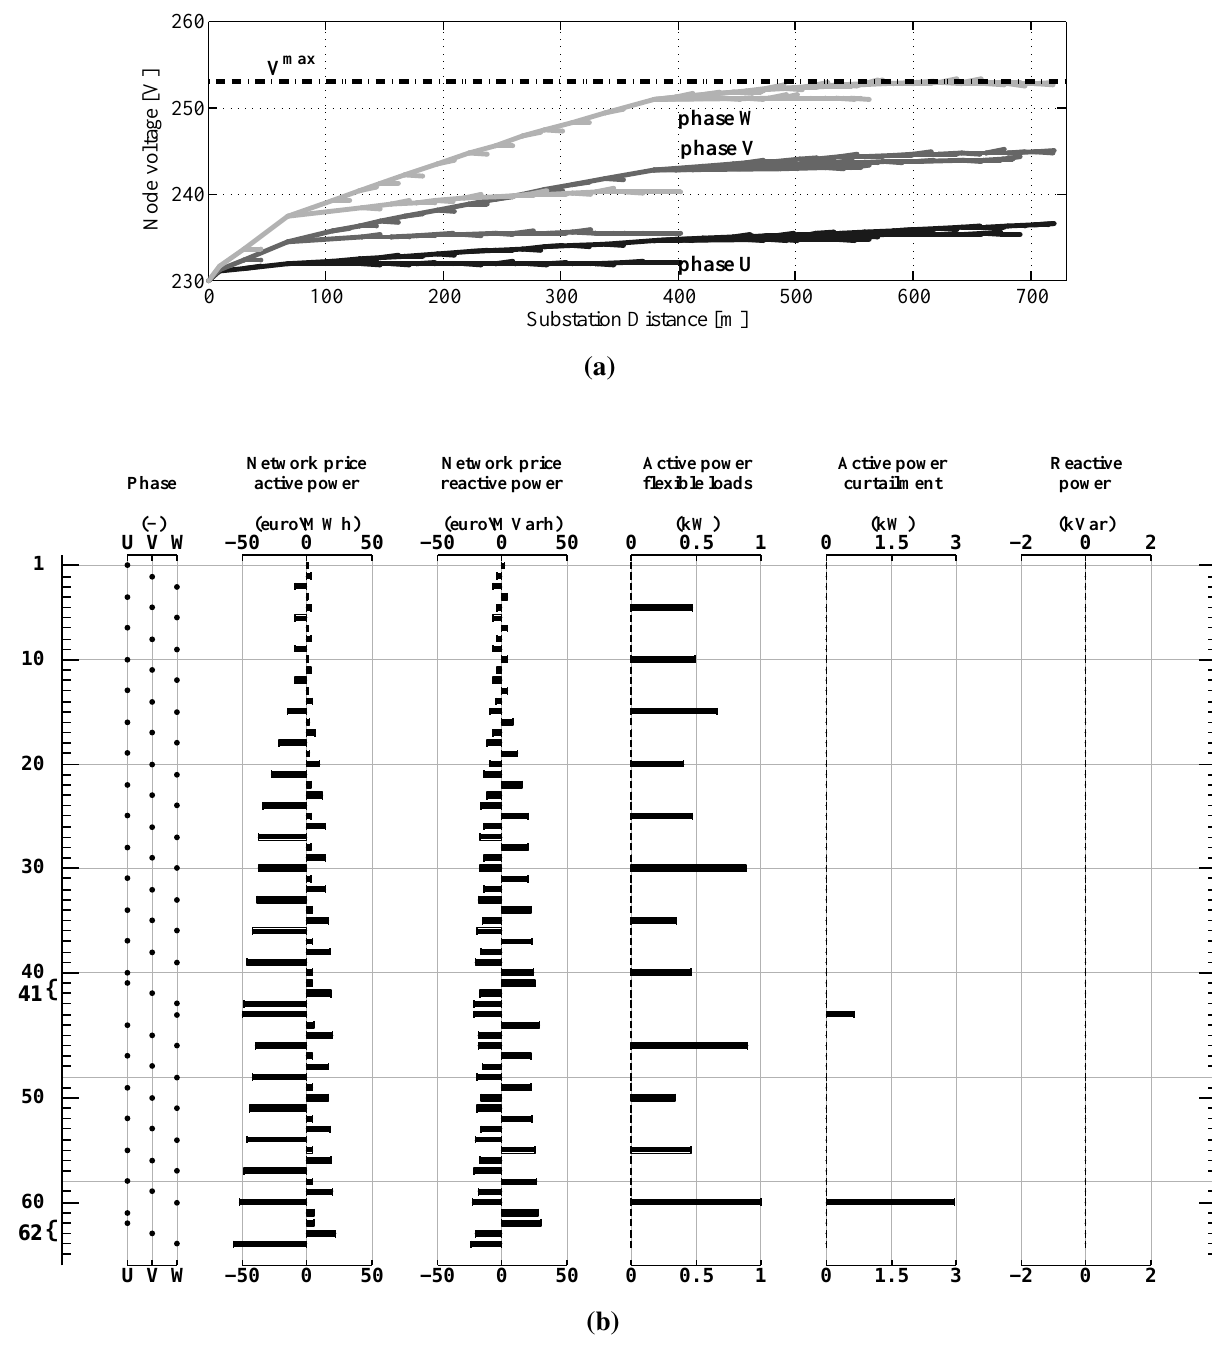
Figure 6. Results of a pricing scheme that gives incentives to adapt flexible consumption and to curtail PV power. ( a ) Grid voltages; ( b ) network prices, flexible consumption, curtailed PV power and reactive power provided by PV panels for each node of the